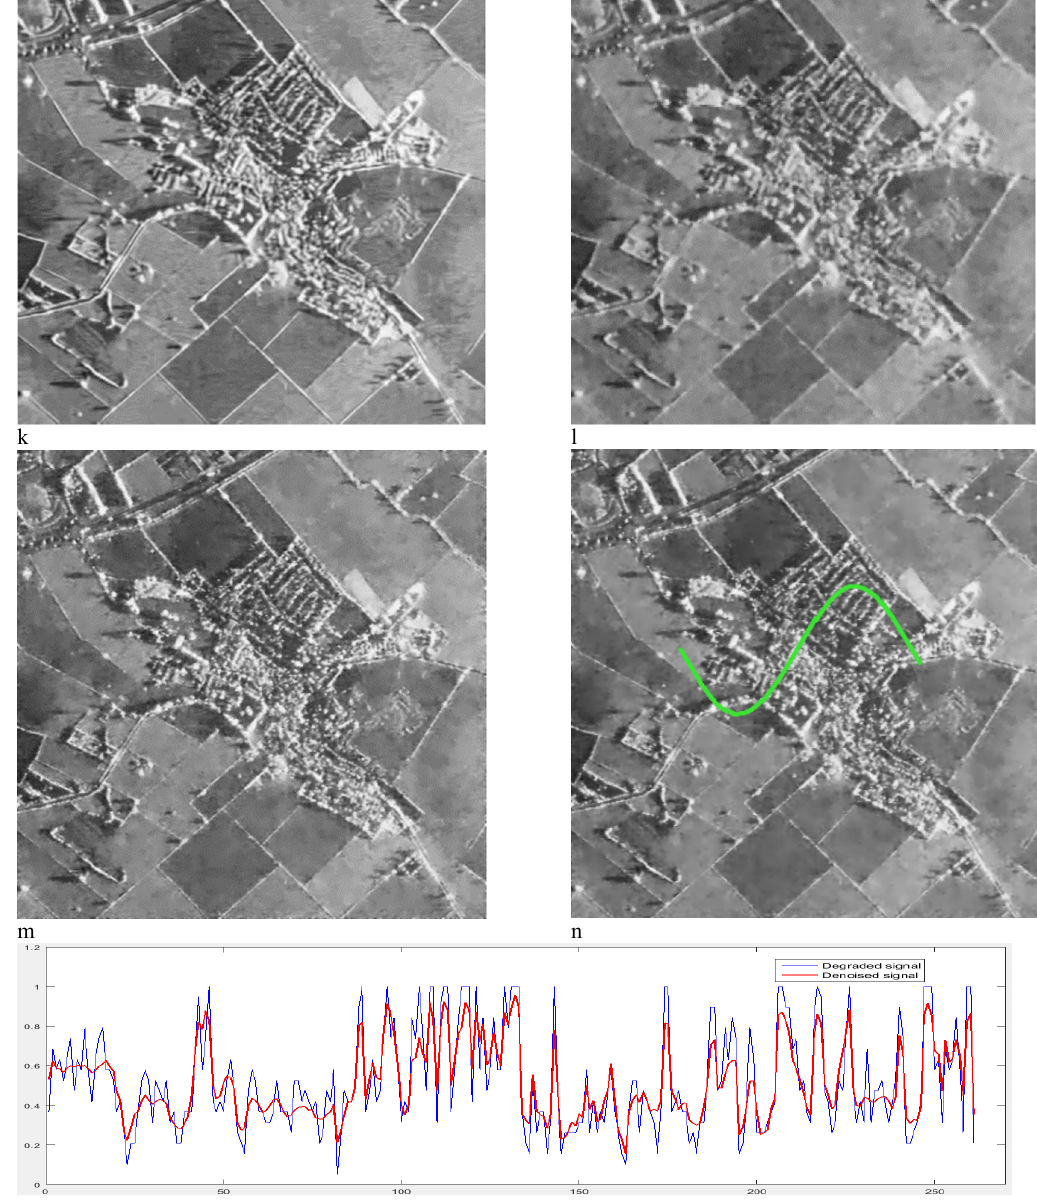
Figure 11. Performance comparison of different techniques in SAR image 2. ( a ) Noisy; ( b ) guided; ( c ) Frost; ( d ) Lee; ( e ) bitonic; ( f ) WLS; ( g ) NLLR; ( h ) ADMSS; ( i ) SRAD; ( j ) SRAD-guided; ( k ) SAR-BM3D; and ( l ) proposed method of Choi et al. ( m ) Proposed method, ( n ) signal on image ( o ) Comparison of the denoised signal and degraded signal.